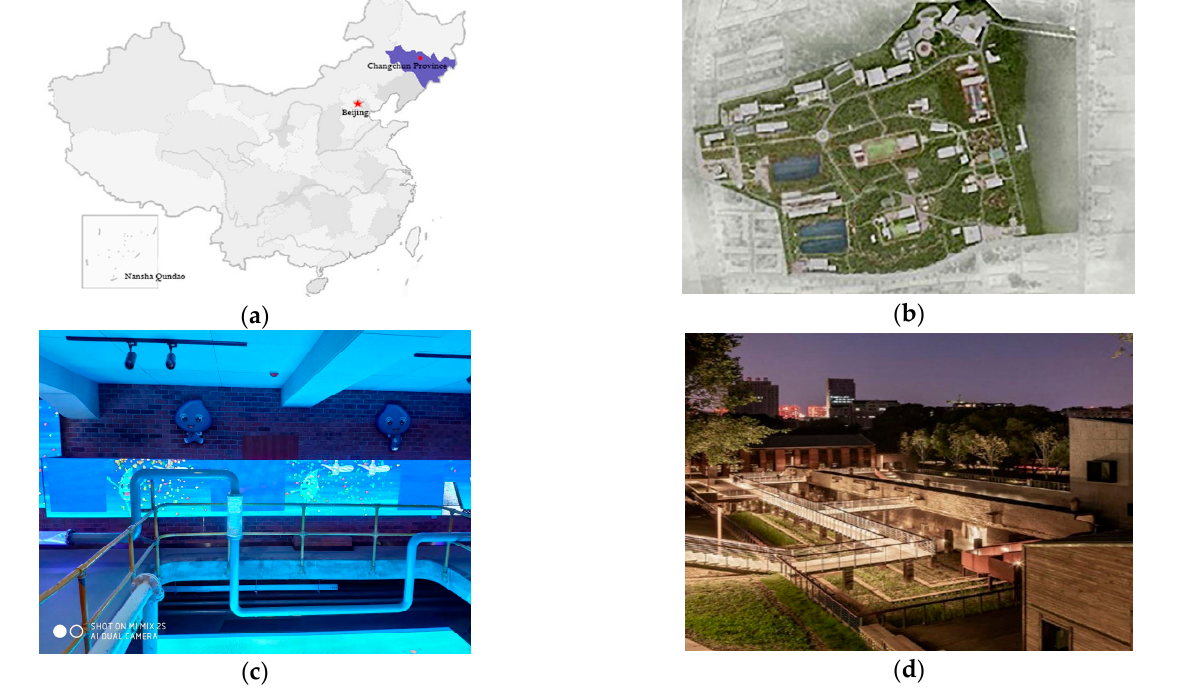
Figure 1. Maps and photos of the study area. ( a ) Location of Water Culture Ecological Park. ( b ) Aerial view of Water Culture Ecological Park. ( c ) Water purification flowchart. ( d ) Water purification plant sites.